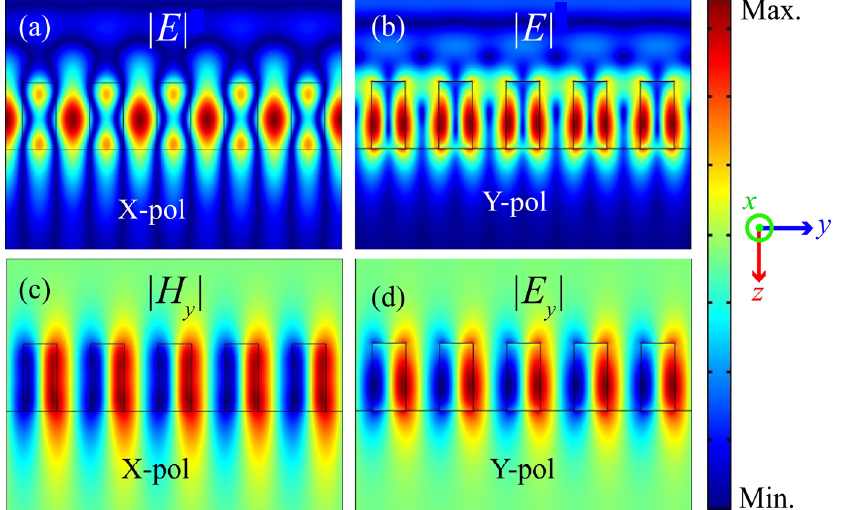
Figure 4. Normalized electric field intensity (| E |) profiles corresponding to λ r of 619 nm and 653 nm for ( a ) X-pol and ( b ) Y-pol lights, respectively. BIC eigenmode profiles of Si 3 N 4 grating system, i.e., ( c ) | H y | in X-pol and ( d ) | E y | in Y-pol light, at eigenfrequency of 484.3 THz and 459.1 THz, respectively.